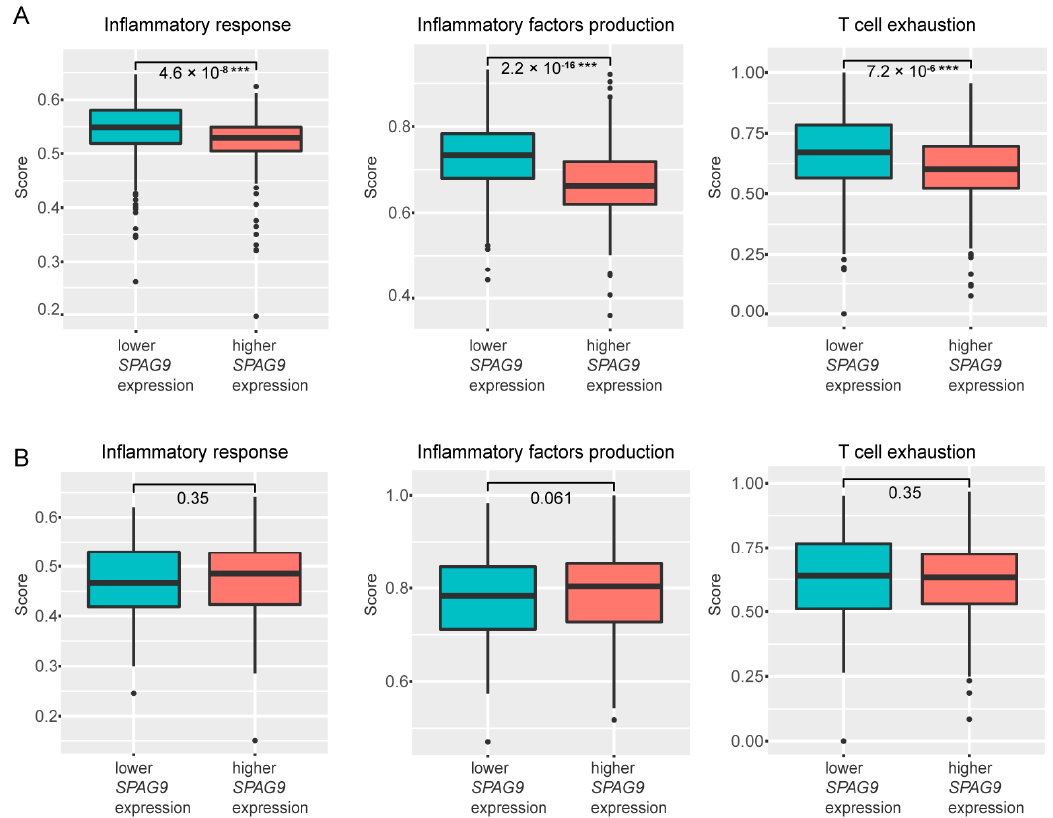
Figure 4. The scores of in fl ammatory response, in fl ammatory factor production, and T-cell exhaus- in ( A ) ccRCC tissues and ( B ) BLCA tissues with different levels of SPAG9 expression. Median SPAG9 tion in ( A ) ccRCC tissues and ( B ) BLCA tissues with di ff erent levels of SPAG9 expression. Median expression was chosen as the group cutoff. *** p value < SPAG9 expression was chosen as the group cuto ff . *** p value < 0.001.